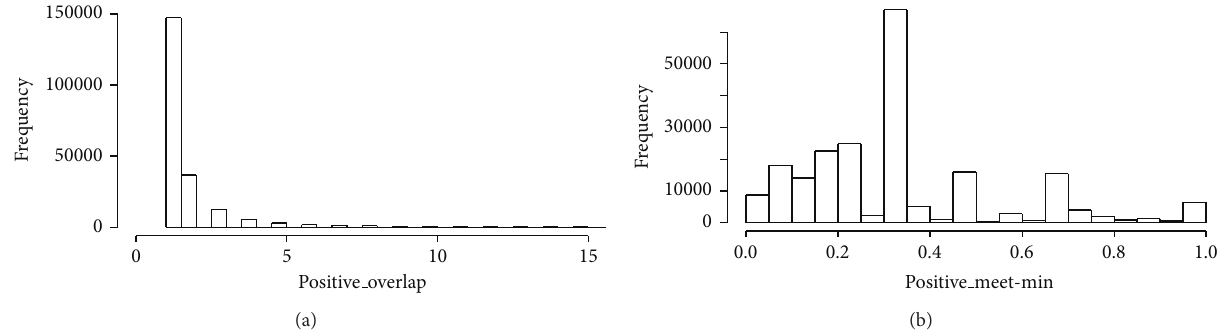
Figure2: Distributionofoverlap (intersection)and nesting (meet-minindex) between every pair of iRefIndex proteincomplexes. (a)Overlap distribution. (b) Nesting